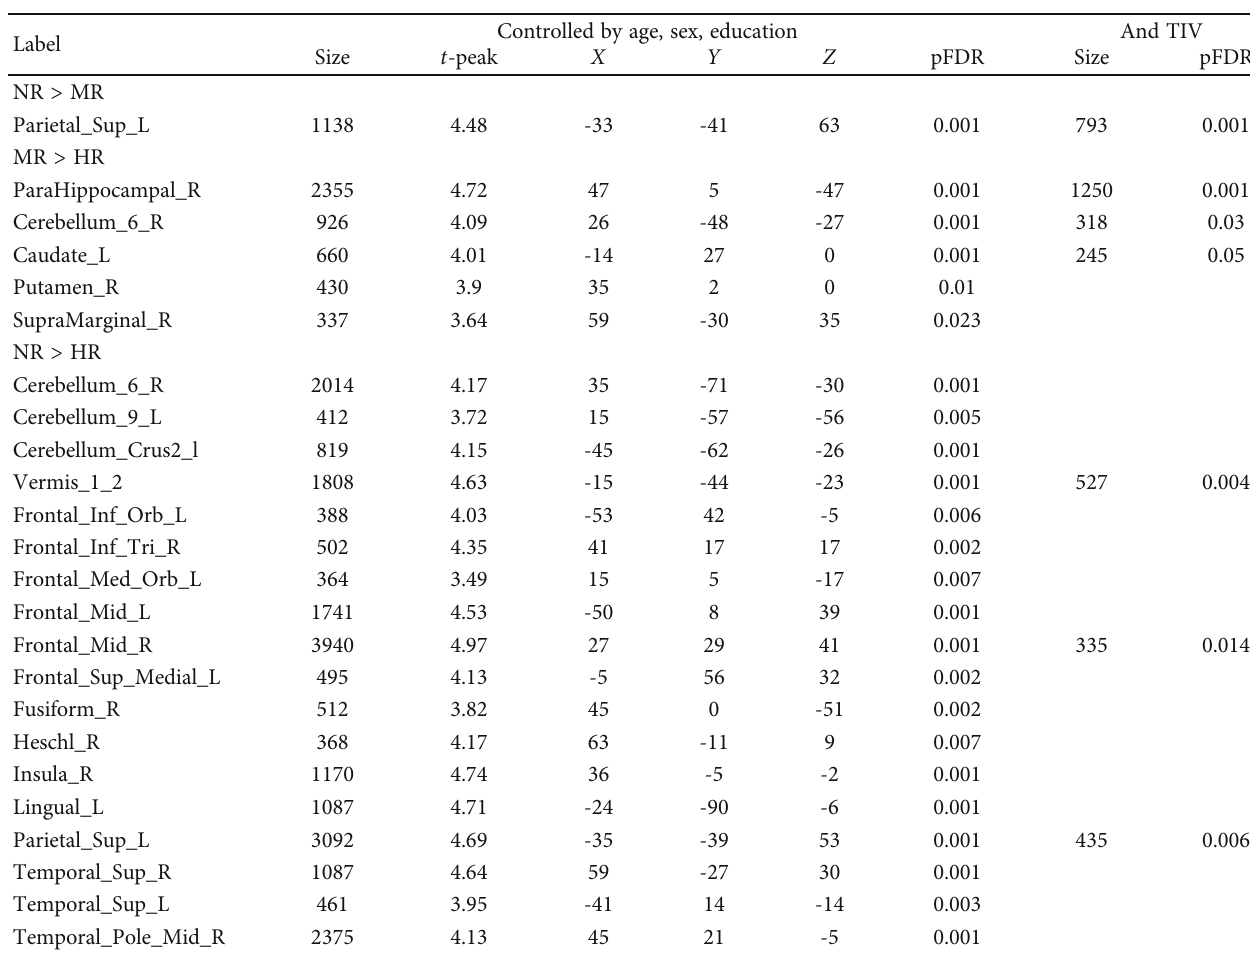
Table 2: Between-group comparisons in brain gray matter volume, adjusted for age, sex, and cultural level (left) and also by total intracranial volume